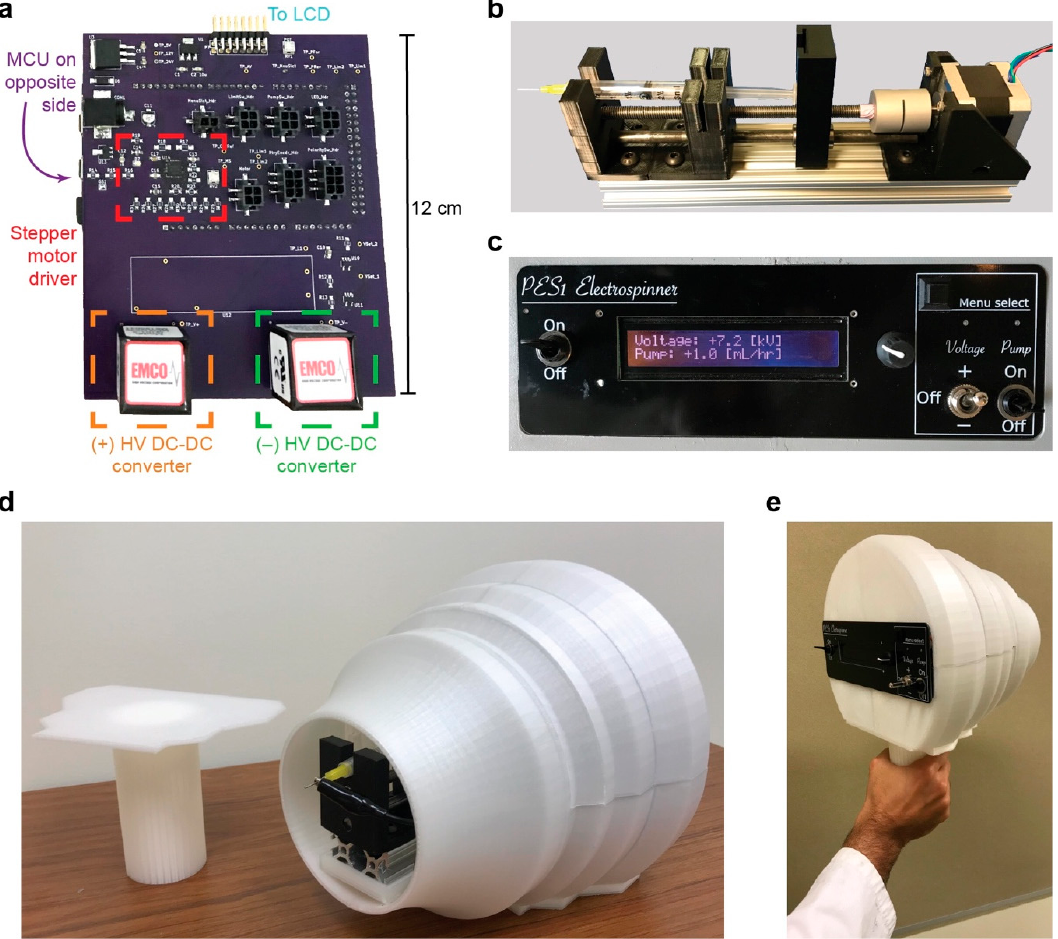
Figure 1. Handheld electrospinner device. ( a ) Main PCB with two HV DC-DC converters: positive (left) and negative (right). ( b ) Syringe pump driven by a stepper motor. ( c ) Front panel user interface. Fully constructed handheld electrospinning apparatus with ( d ) the handle detached and ( e ) the handle